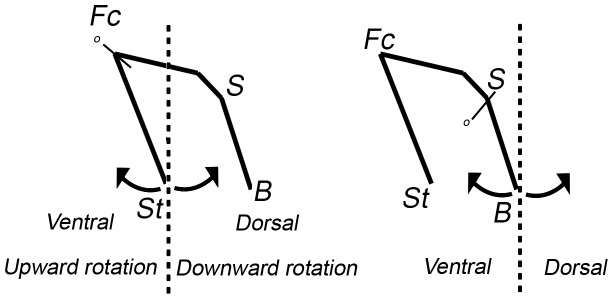
Example of the rotation of the staphylion (left) and of the basion (right).In this paper, rotation is considered as ventral if the distal end of the segment is displaced forward relative to the other end of the segment. It is considered as dorsal if it is displaced backward. St: staphylion, Fc: Foramen caecum, S: Sella turcica, B: Basion.